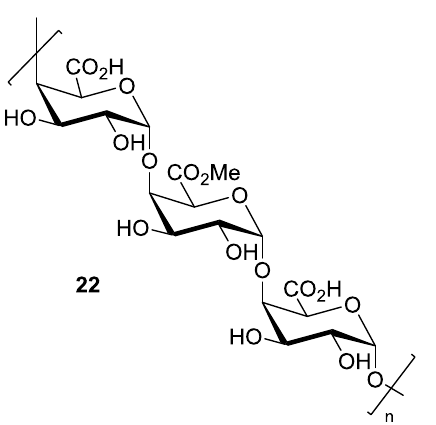
Figure 8. The polysaccharide pectin used for supporting PdNPs and catalyze the Sonogashira cross-coupling reaction.